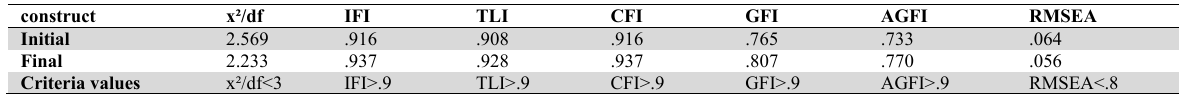
Measurements of PV-EGOV model construct